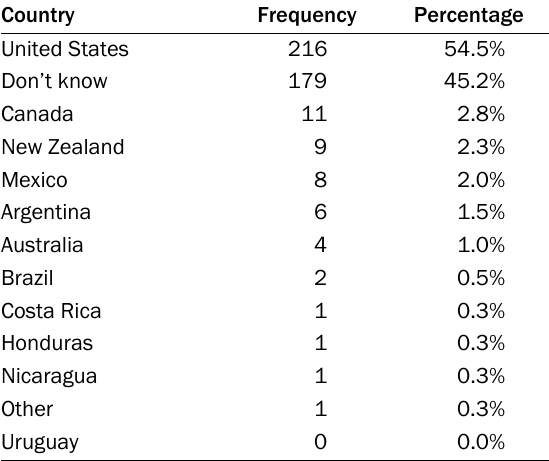
Table 1. Country-of-Origin for Last Beef Product